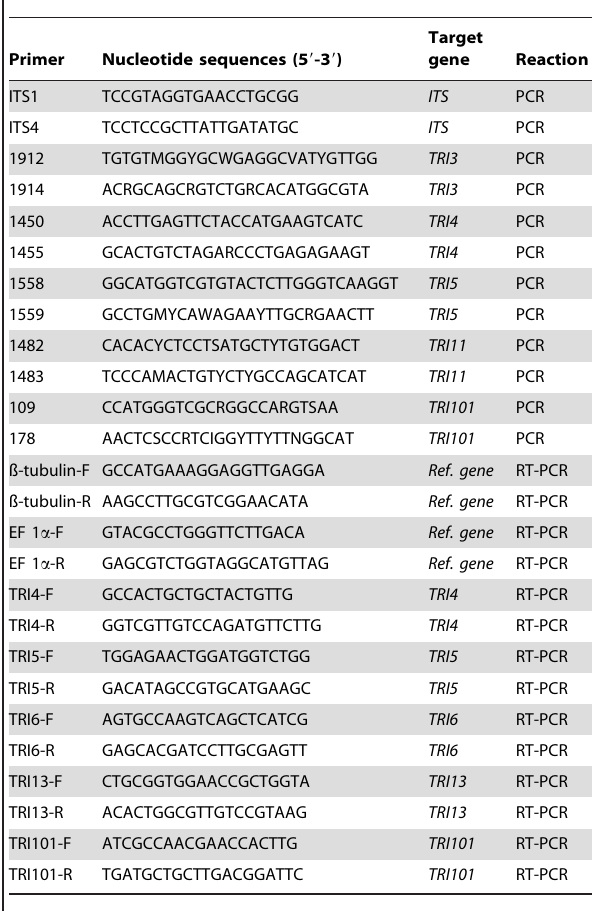
Table 1. Primers sets used for PCR and RT-PCR